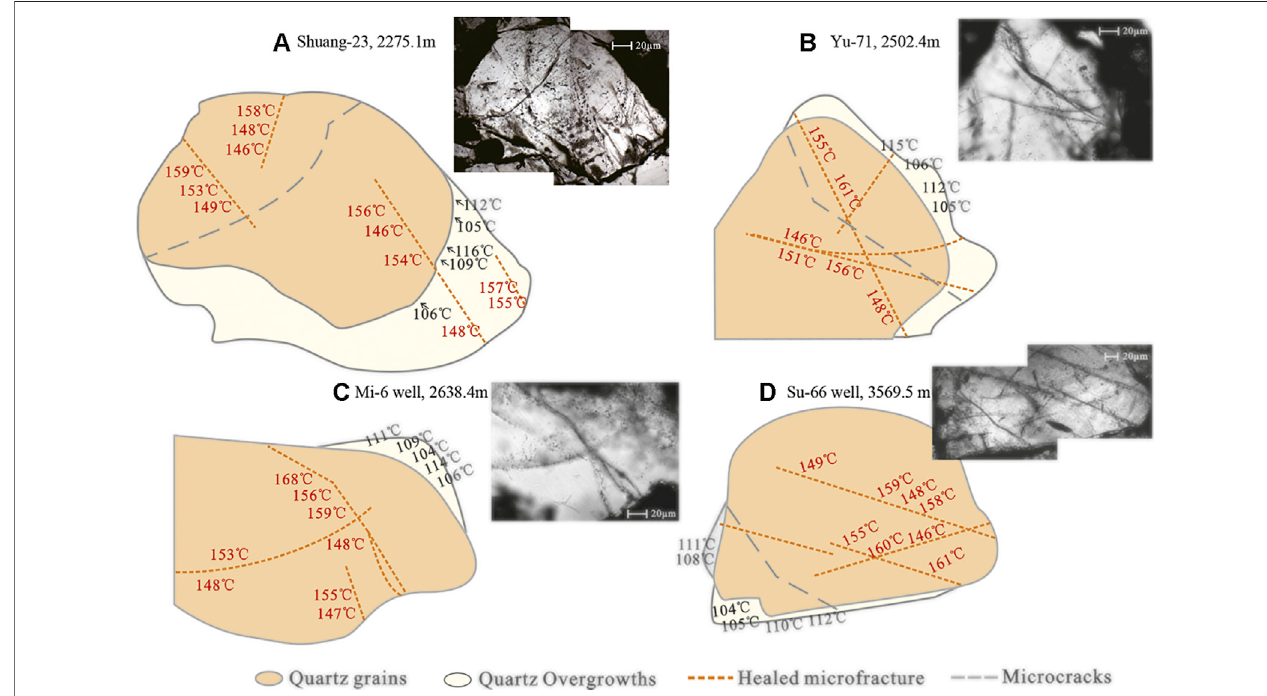
FIGURE 4 | Homogenization temperature of fl uid inclusions in different FIAs.